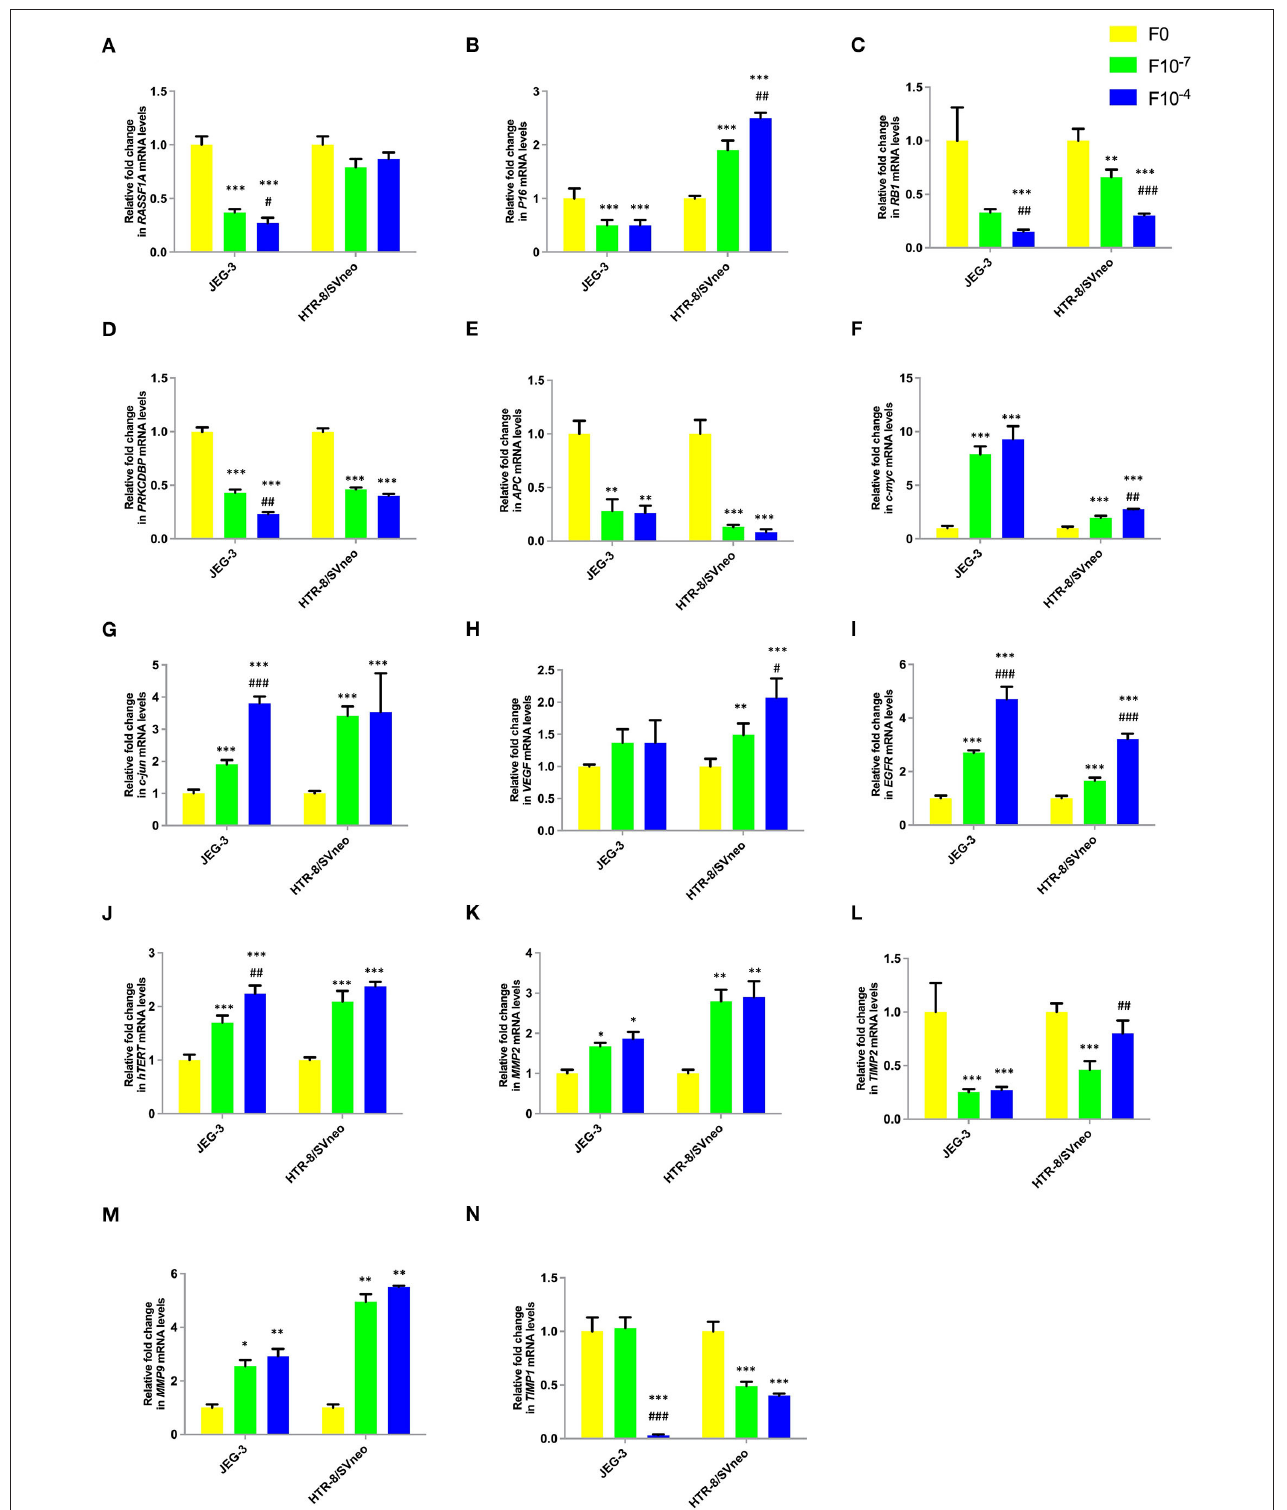
FIGURE 6 | Effect of folic acid supplementation on mRNA levels of specific genes in JEG-3 and HTR-8/Svneo cell lines. Relative fold in mRNA levels of levels of (A) RASSF1A (B) P16 (C) RB1 (D) PRKCDBP (E) APC (F) c-myc (G) c-jun (H) VEGF (I) EGFR (J) hTERT (K) MMP2 (L) TIMP2 (M) MMP9 (N) TIMP1 F0- without folic acid supplementation, F10 − 7 and F10 − 4 - folic acid supplementation at the concentration of F10 − 7 and F10 − 4 M, respectively. The data are expressed as mean ± SEM of three experiments. * p < 0.05, ** p < 0.01, *** p < 0.001 with respect to the F0 control and # p < 0.05, ## p < 0.01, ### p < 0.001 with respect to the F10 − 7 treated